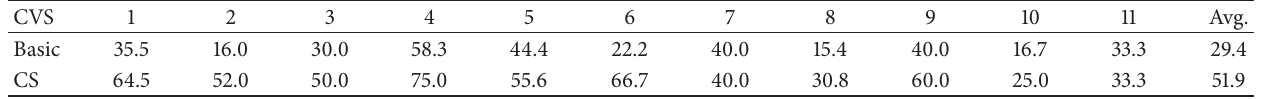
Table 2: Accuracy rates for each individual actor.